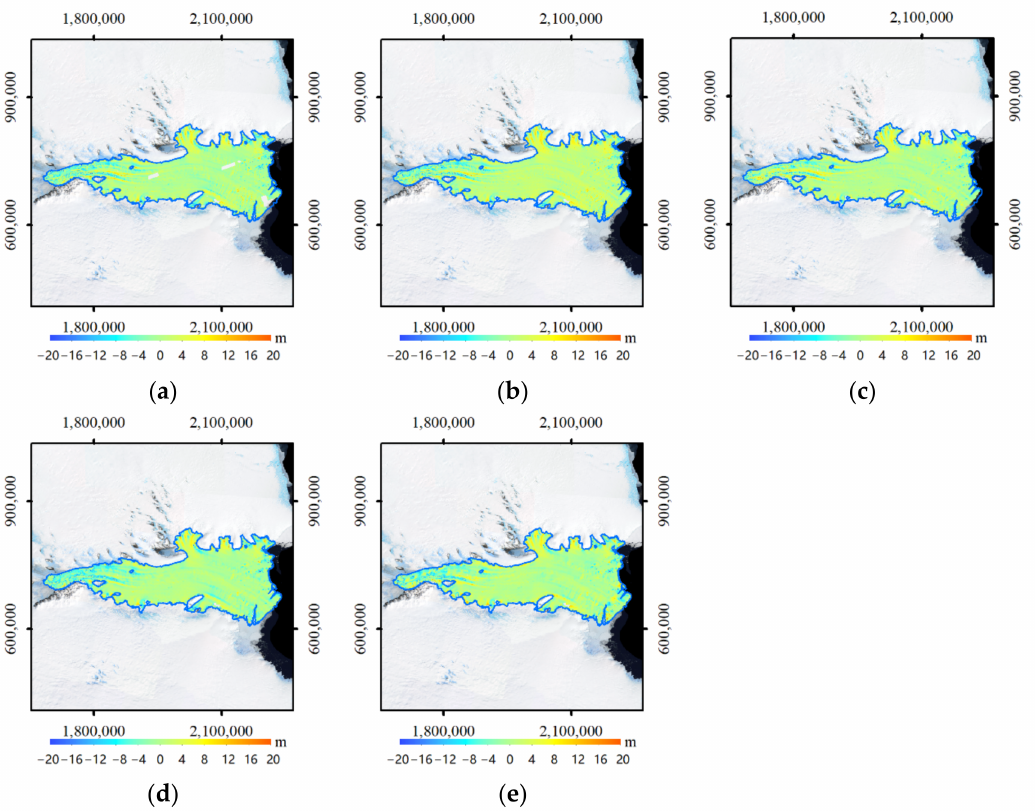
Figure 8. Distribution of elevation differences between the ICESat-2 AIS DEM and five previously published Antarctic DEMs, i.e., REMA ( a ), TanDEM PolarDEM ( b ), Slater CryoSat-2 DEM ( c ), Helm CryoSat-2 DEM ( d ), Bamber DEM ( e ). Maps are in the polar stereographic projection in meters.